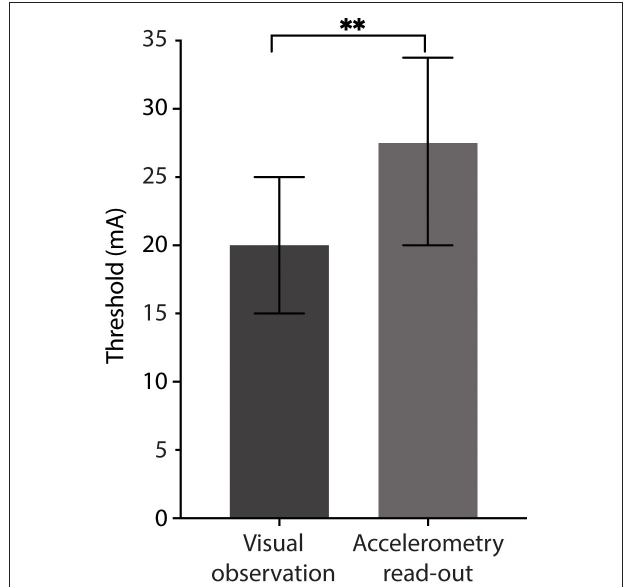
FIGURE 2 | Stimulus threshold required to elicit visual thumb twitch and accelerometry. Median stimulus thresholds for visual thumb twitch and accelerometry read-out. ** p < 0.01, unpaired Wilcoxon test.